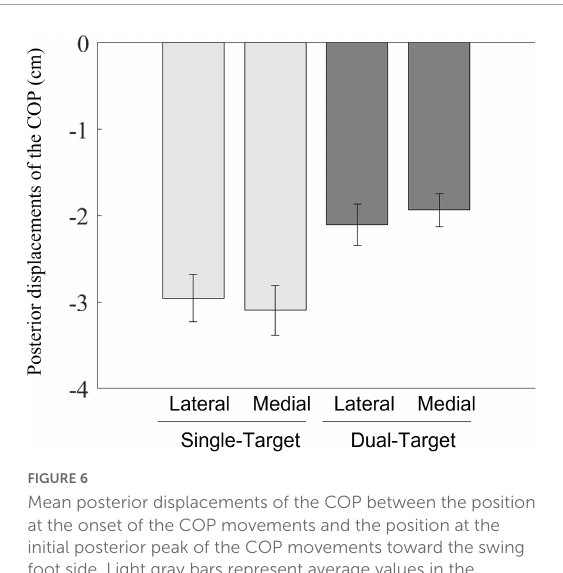
FIGURE6 Mean posterior displacements of the COP between the position at the onset of the COP movements and the position at the initial posterior peak of the COP movements toward the swing foot side. Light gray bars represent average values in the single-target condition, and dark gray bars represent average values in the dual-target condition. Error bars represent standard errors of the